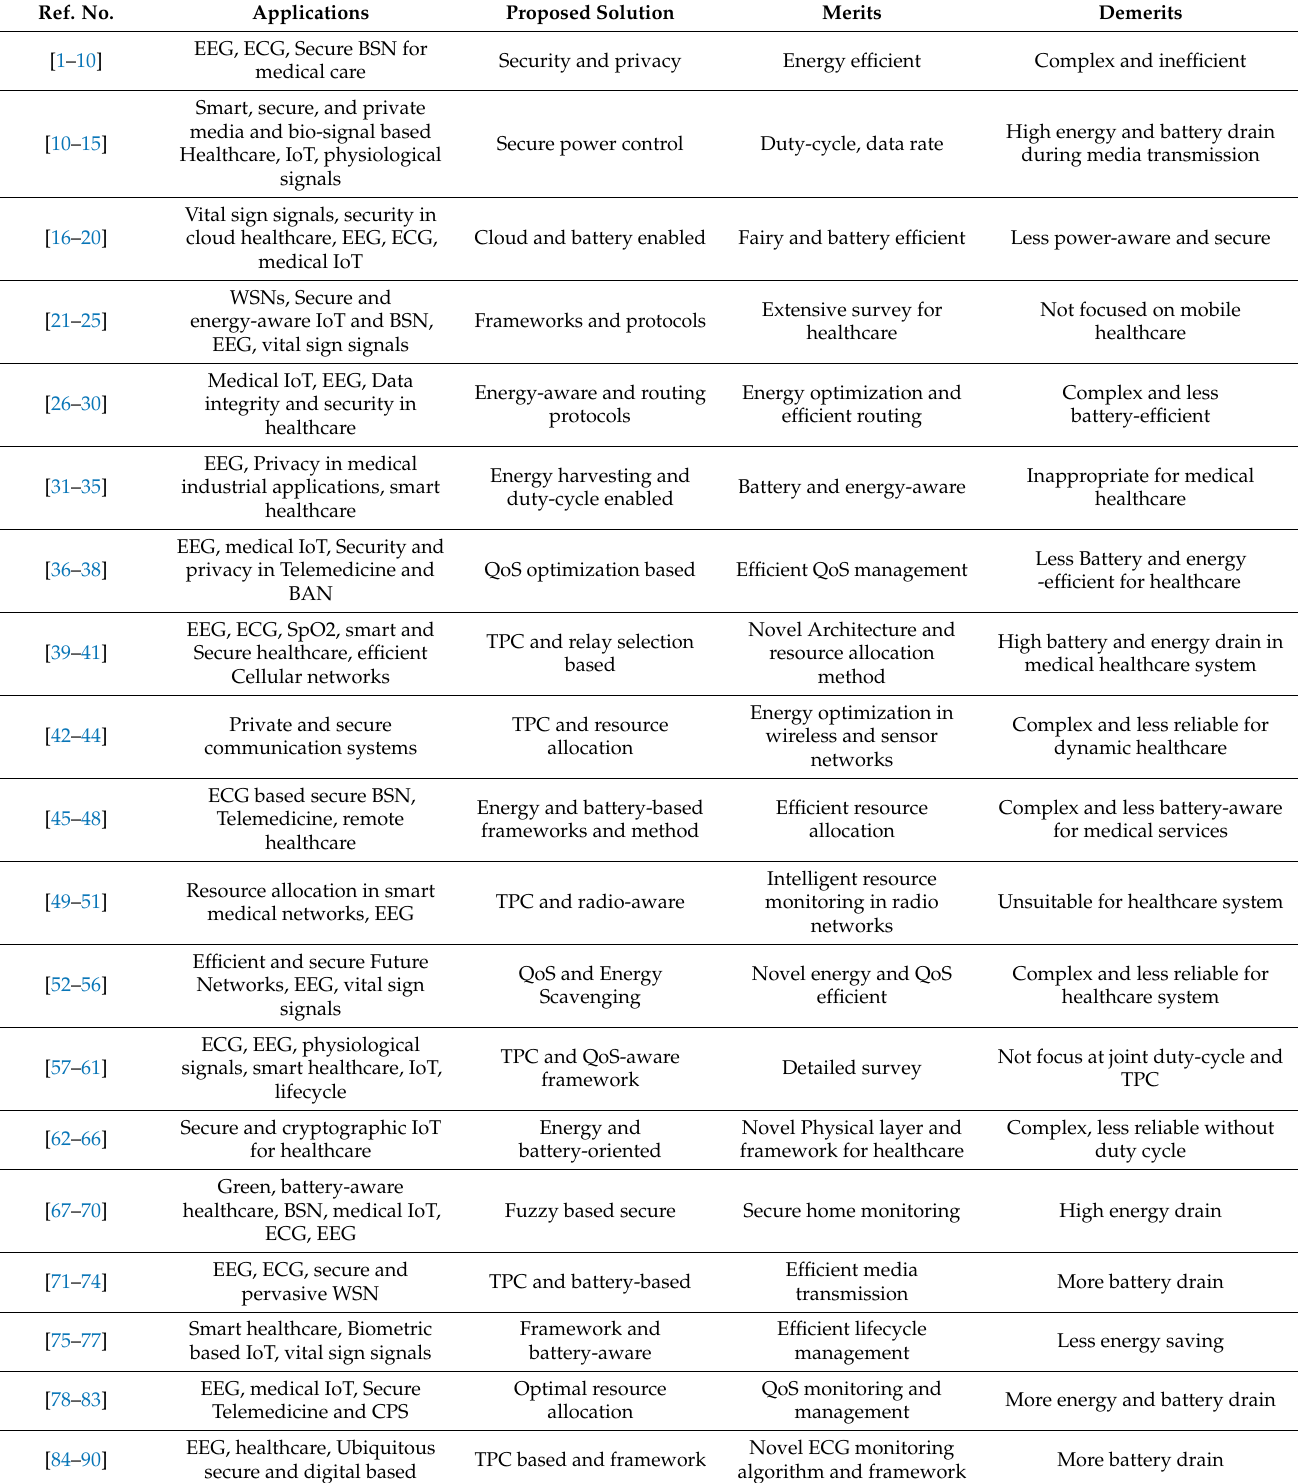
Table 1. Related